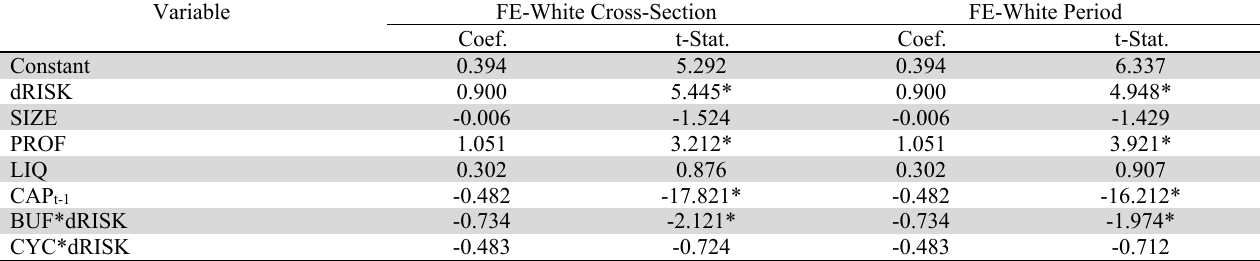
The Results of Risk Adjustments Based on FE with Robust Standard Error Variable FE-White